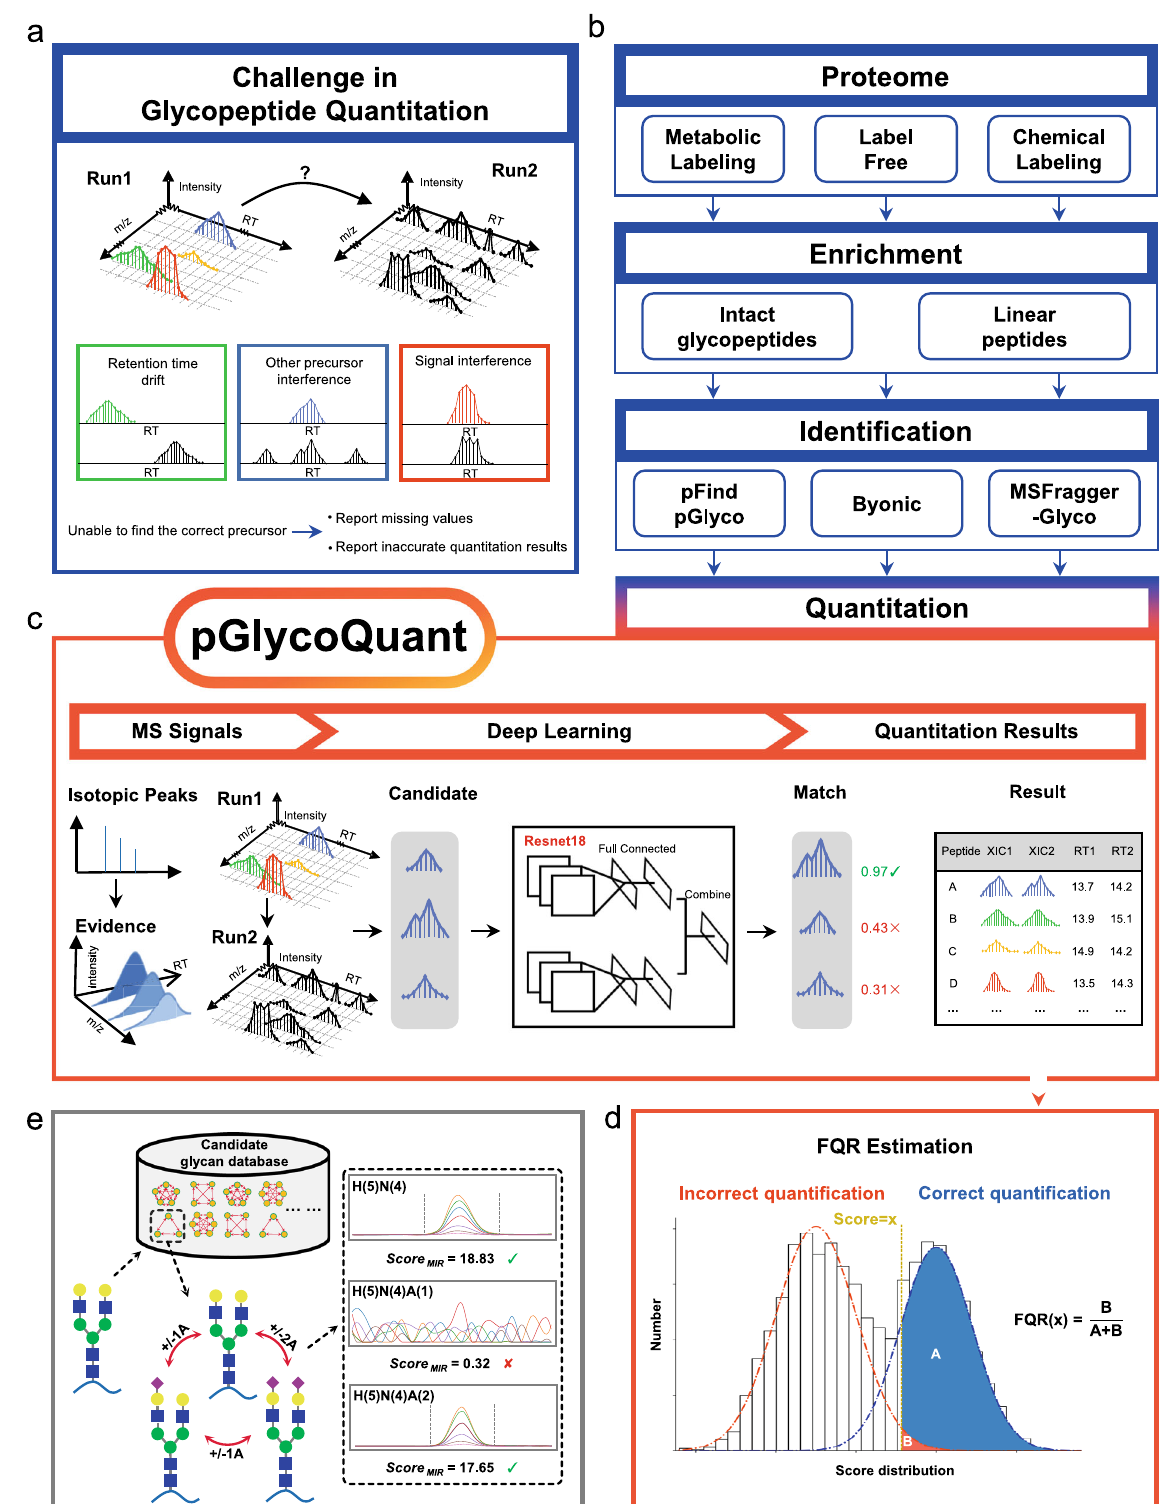
Fig. 1 | The development of pGlycoQuant. a Current glycopeptide quantitation softwaretoolssufferfromsuboptimalreproducibilityforlower-abundancesignals, resulting in a high missing value rate. b pGlycoQuant supports both primary and tandem mass spectrometry quantitation for multiple quantitative strategies. c An embedded deep learning model of ResNet in pGlycoQuant for glycopeptide